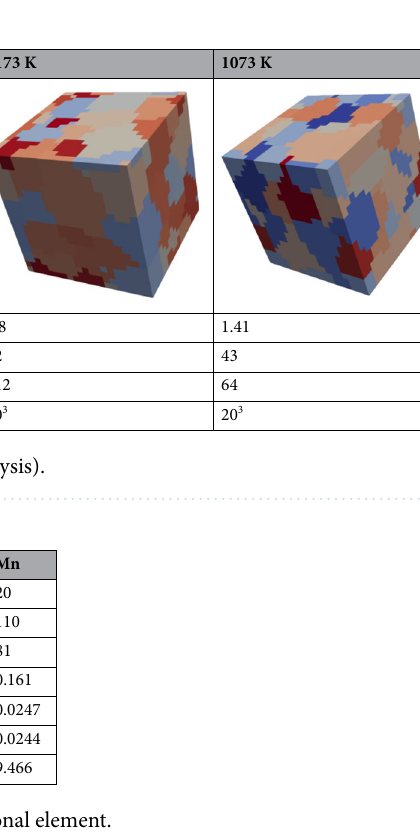
Table 3. Material parameters of each compositional element.